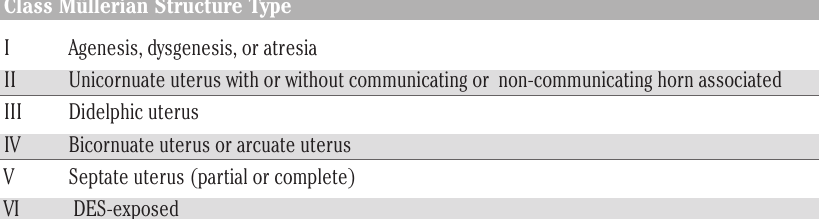
Table 4. Classification systems for congenital uterine anomalies according to American Society of Reproductive Medicine.